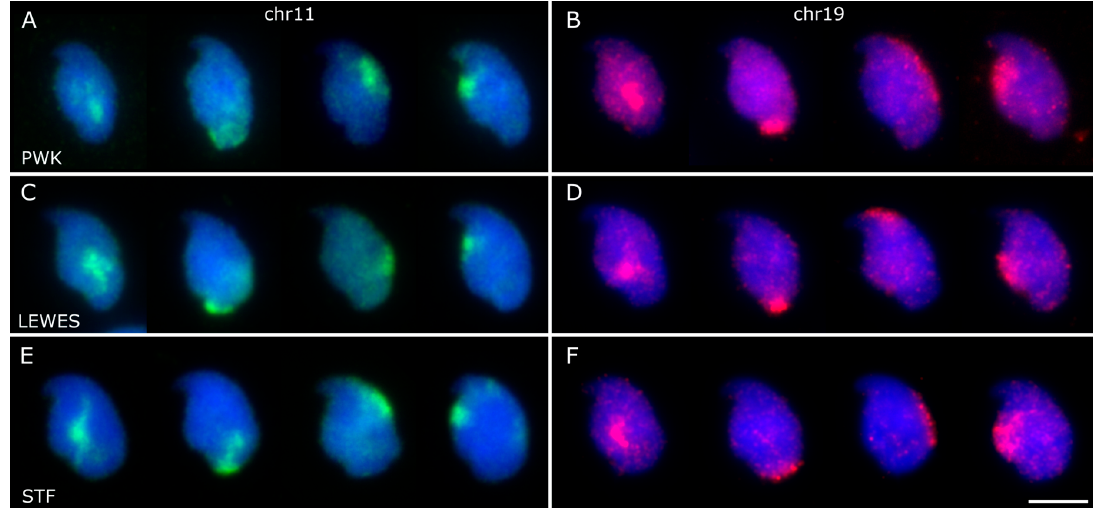
Figure 5. Examples of individual chromosome positions for chr11 ( A , C , E ) and chr19 ( B , D , F ) in the three strains; the chr11 and chr19 panels do not show the same nuclei. While the majority of the signals for each chromosome were observed ventral and basal of the nuclear centre (column 1), we found territories at the base of the nucleus (column 2), under the acrosome (column 3), and along the ventral surface below the hook (column 4). Scale bar represents 5 μ m.